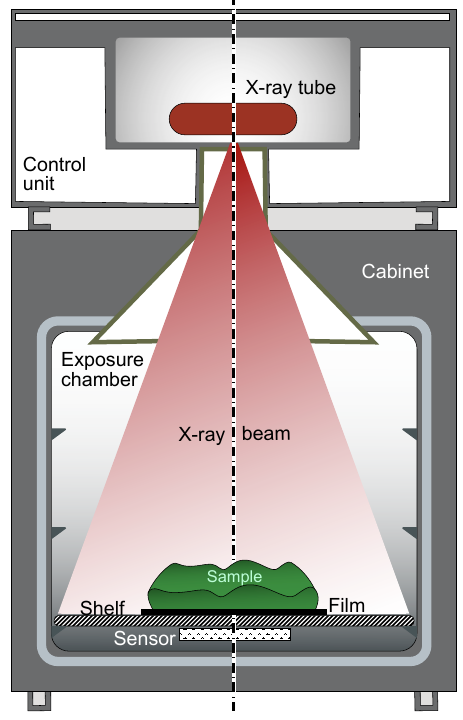
Figure 5. Schematic drawing of an X-ray device of the FAXITRON series (Hewlett-Packard), which has an upper chamber for the X-ray tube with a control unit and an exposure chamber below (Faxitron X-ray Corporation, 1975). X-ray cone is shown in red. Both are fully lead shielded allowing for operation under normal laboratory conditions without special protection of registration. The sensor be- low the sample shelf can be used to set automatic exposure times. In modern digital operation mode, shelf, film and sensor are replaced by a scanner sensitive to X-ray